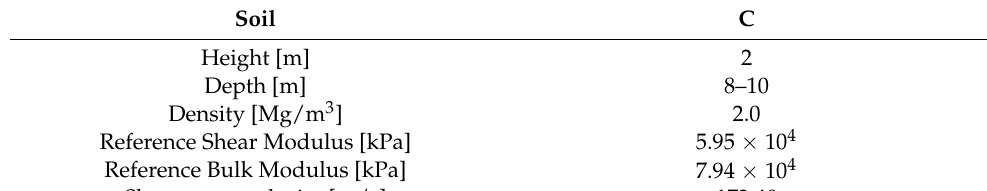
Figure 4. PressureIndependMultiYield (PMIY) model: multi-yield surfaces in principal stress space.